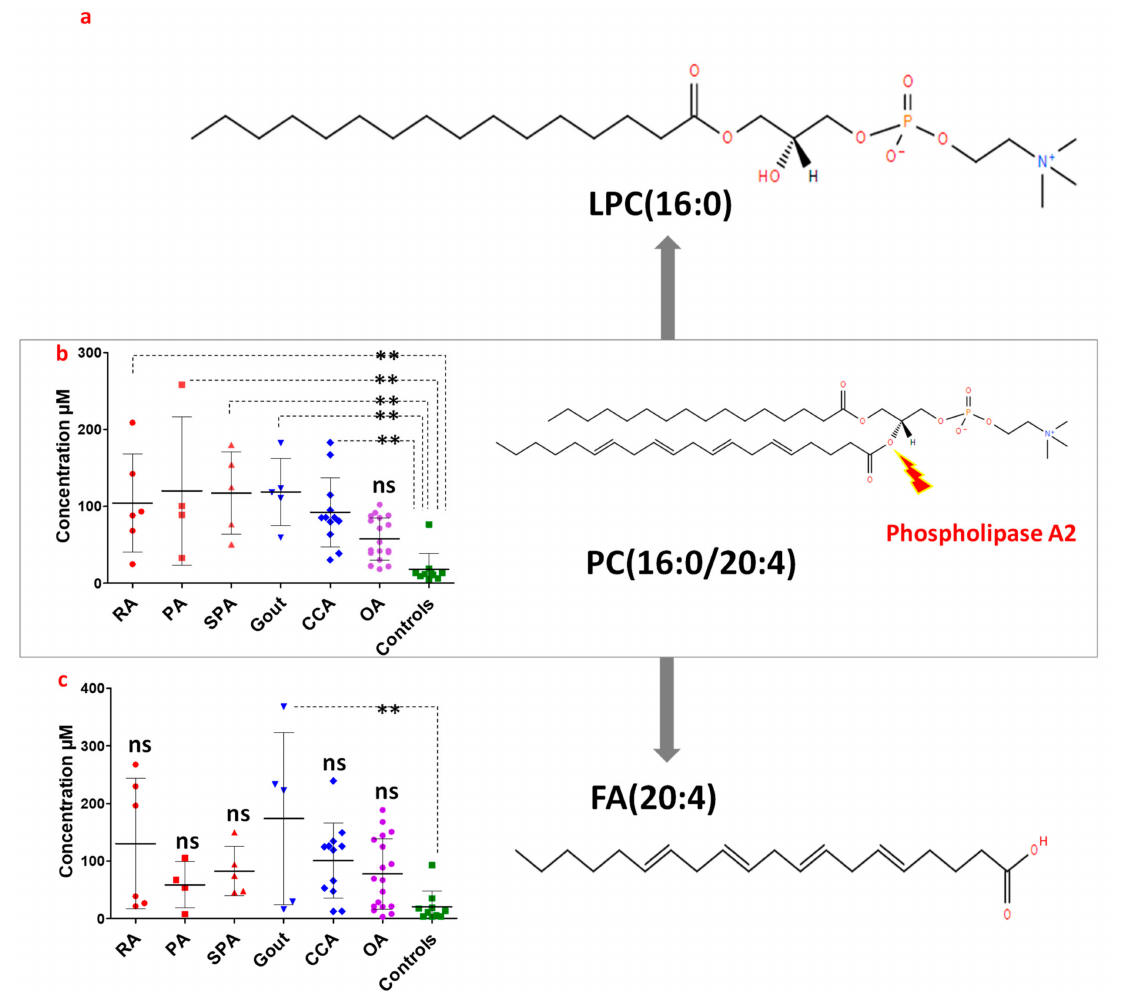
Figure 6. Evaluation of phospholipase A2 (PLA2) role in the variation of LPC16:0 levels in the synovial fluid of patients. ( a ) Represents the structure of LPC16:0. ( b , c ) Represents the concentration (in µ M, left panel) and the structure (right panel) of PC(16:0/20:4) and FA20:4, respectively, in the different rheumatic diseases compared to controls. A one-way analysis of variance completed with the Bonferroni’s Multiple Comparisons Test were performed to compare lipid concentrations in the individual joint pathologies; ns: not significant p > 0.05, **: 0.001 < p <